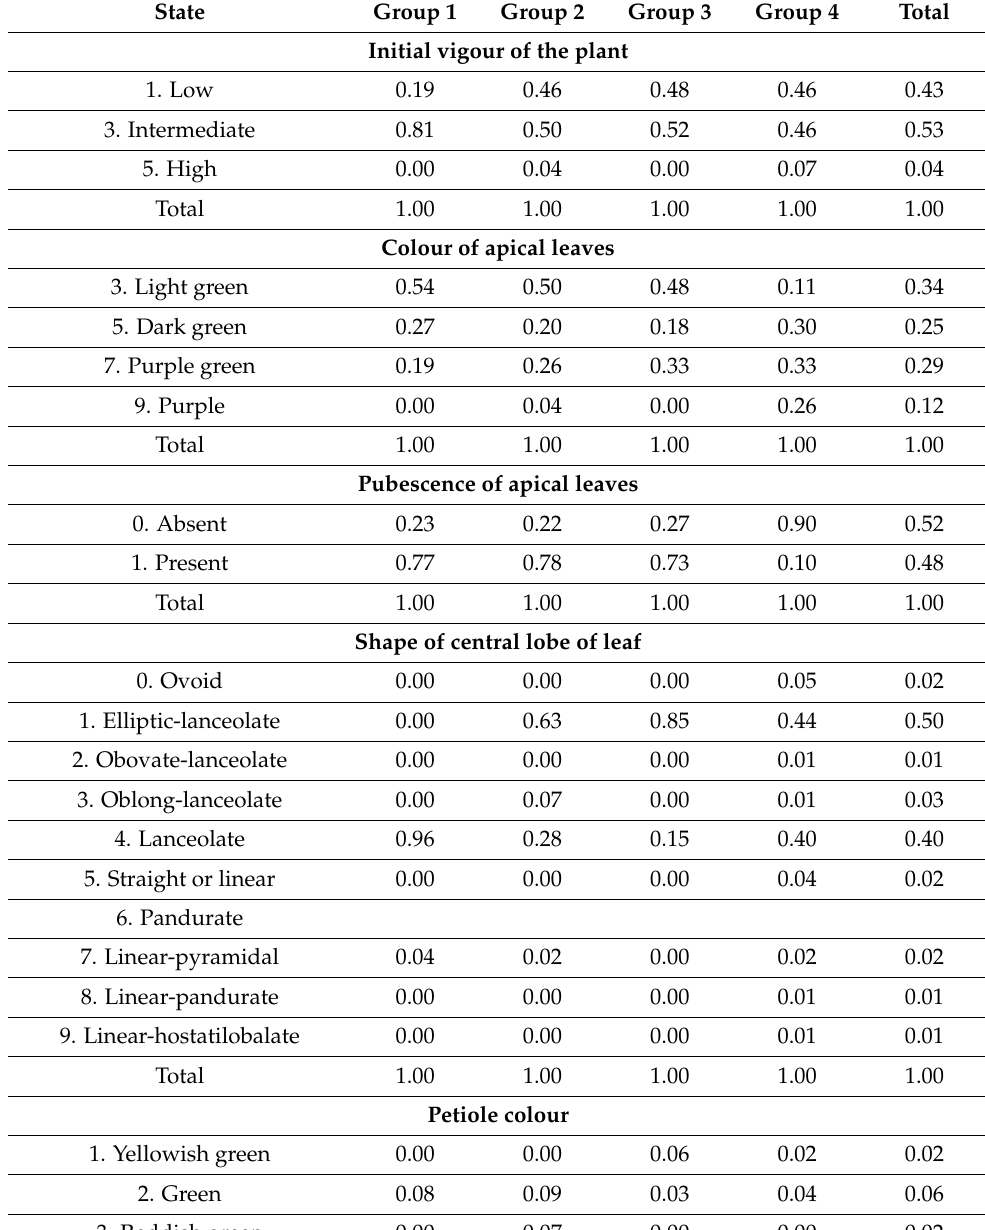
Table A3. Morphological variability in qualitative characters based on the dendrogram groupings of the Ecuadorian cassava